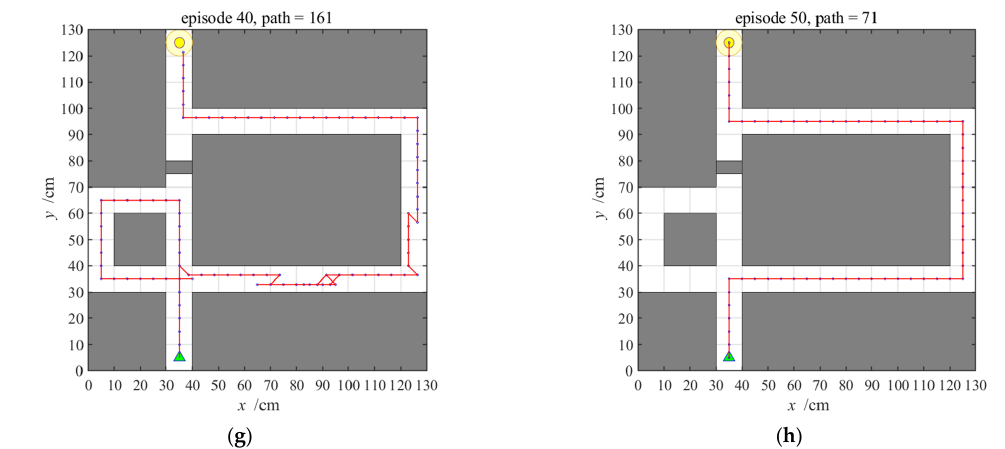
Figure 18. Navigation path with the striatal model alone when door B is closed; ( a ) shows the agent’s encounter with the closed door B, and ( b ) shows the new navigation path from current position, both of which constitute the first navigation path. In addition, ( c – h ) show navigation paths in the 2nd, 10th, 20th, 30th, 40th, and 50th episodes, respectively. The episode number and the path length measured in steps for each experiment are shown at the top of the panels.